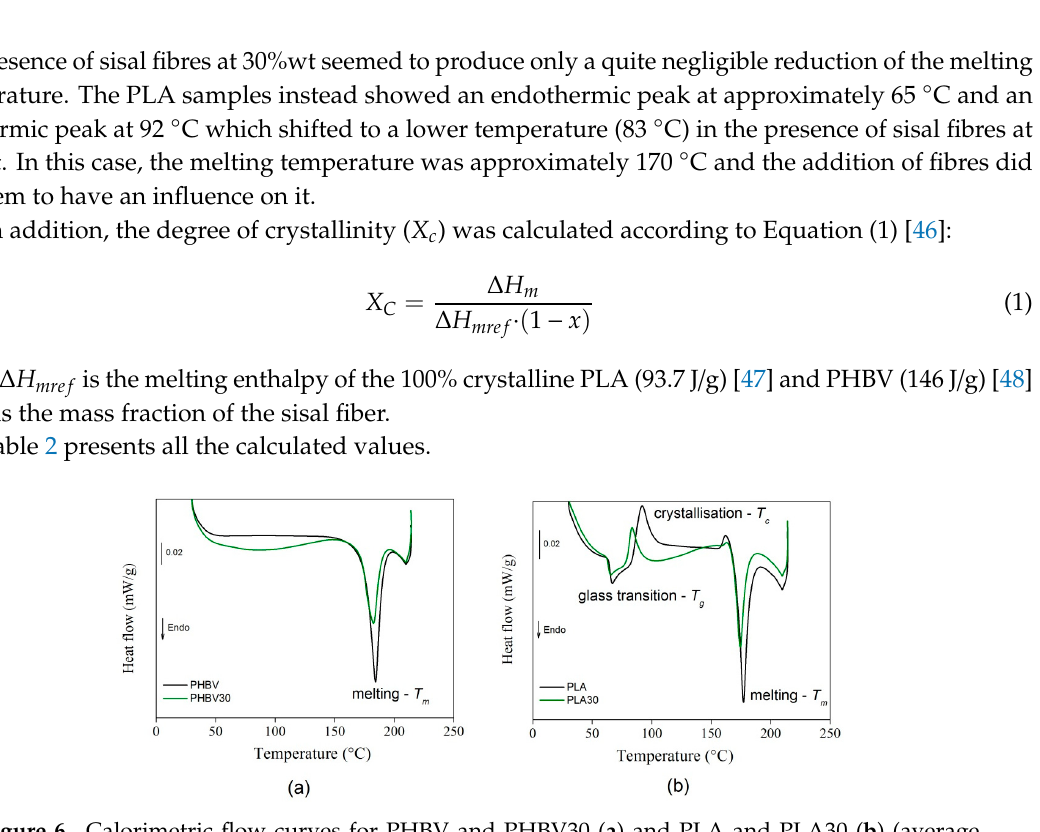
Figure 6. Calorimetric flow curves for PHBV and PHBV30 ( a ) and PLA and PLA30 ( b ) (average error = ± 5%). Table 2. Calorimetric results for PHBV, PLA and their biocomposites–raw materials.